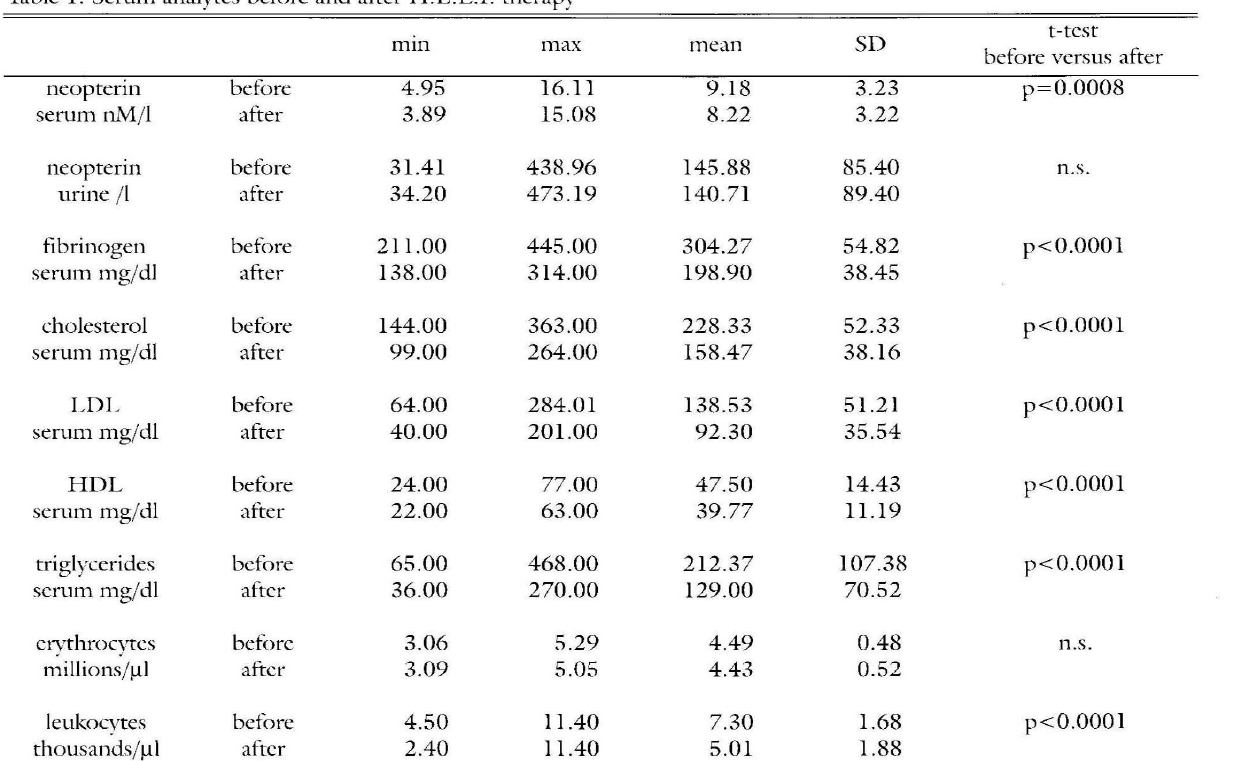
Table 1. Serum analytes before and after H .E.L.P. therapy